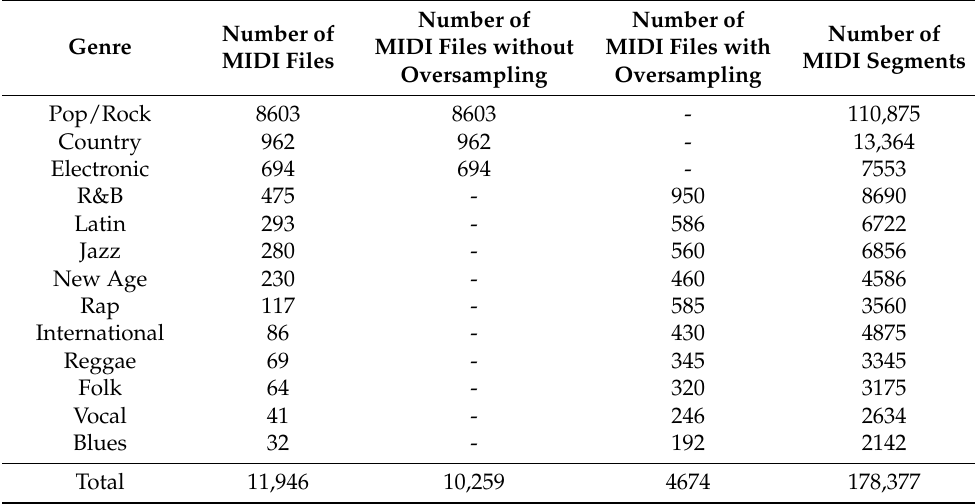
Table 5. The distribution of MIDI files with genre label in the Lakh MIDI Dataset.